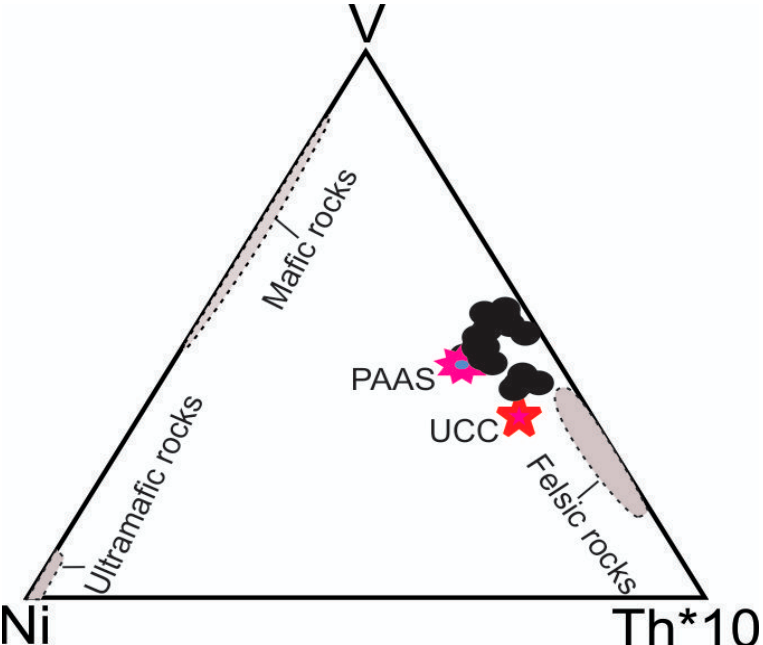
Figure 10. V ‐ Ni ‐ (Th*10) plot for the Brahmaputra River sediments. Shaded areas represent composition of the felsic, mafic and ultramafic rocks. Brahmaputra River sediment samples are represented by the black dots. All data plotted in ppm.